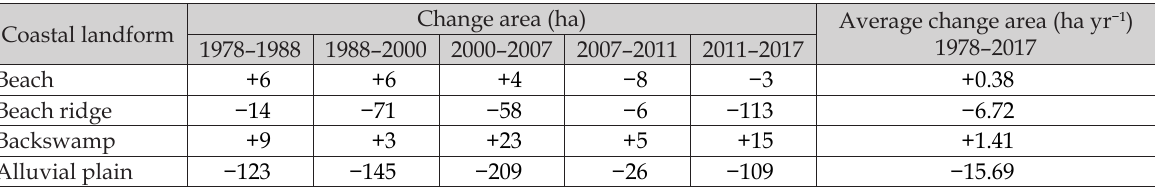
Table 3. The estimate of the average rate area of coastal landform change for the year 1978 to 2017 in study